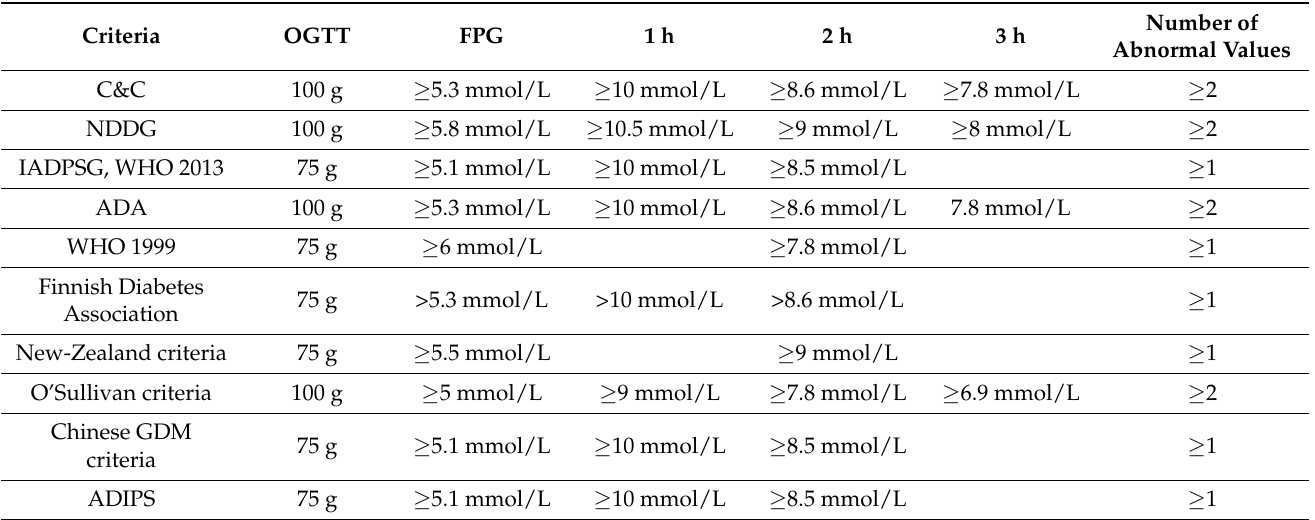
Table 1. This table gives an overview of the gestational diabetes mellitus diagnosis criteria used in this